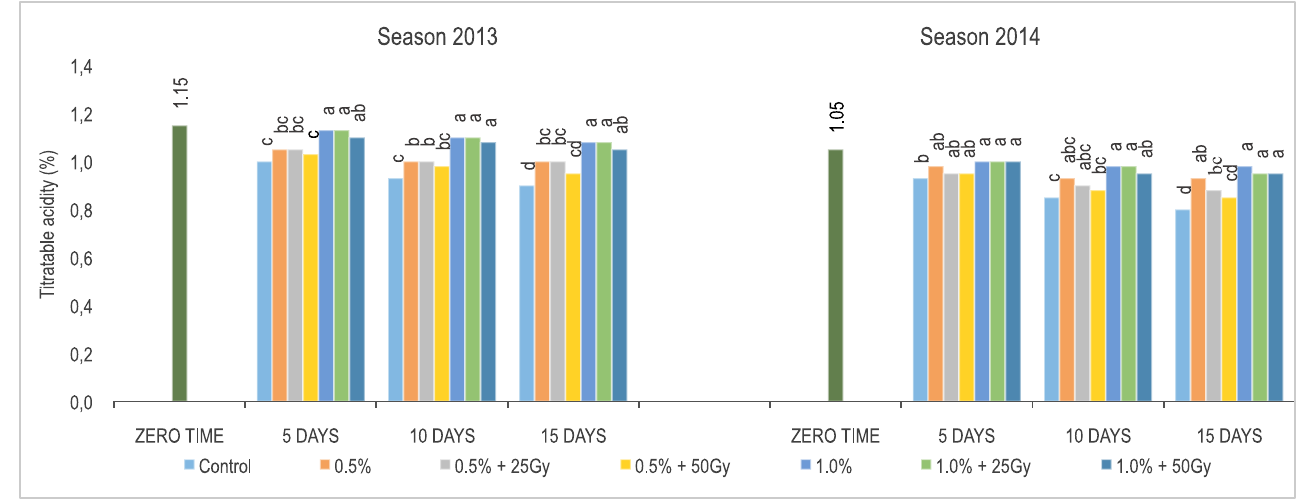
Fig. 2: Effect of irradiated and unirradiated chitosan on arils juice TA (%) during cold storage. Columns in the same group bearing a common letter are insignificantly different at P<0.05.